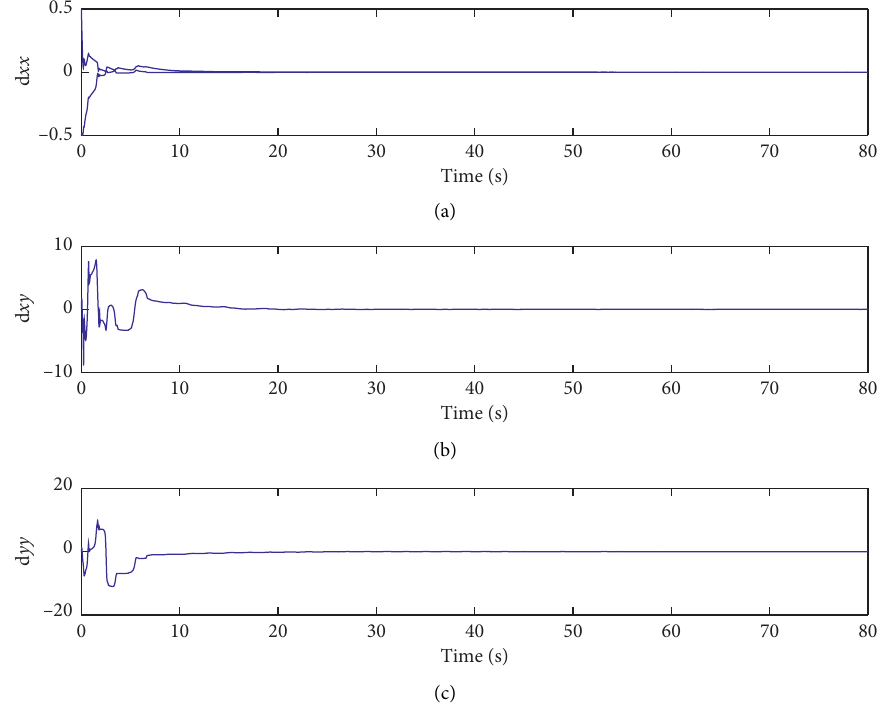
Figure 11: Adaptation of damping coefficients using fractional SMC.